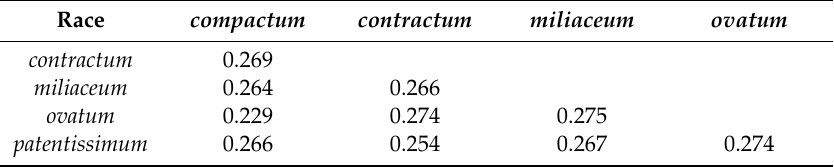
Table 6. Average phenotypic distance among races.